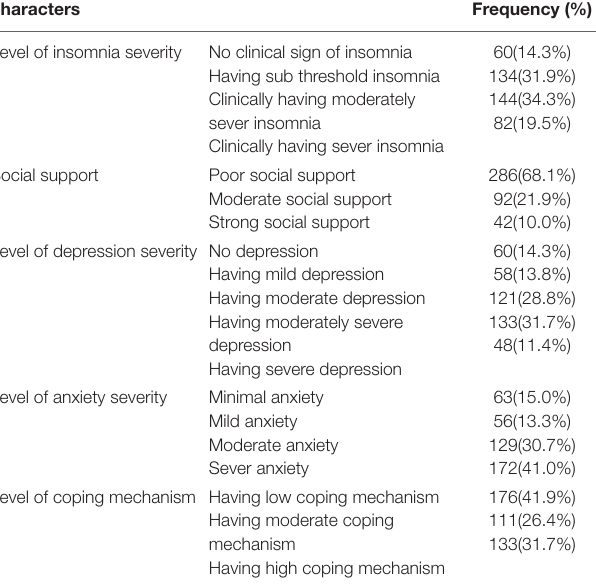
TABLE 3 | Level of severity for insomnia social support, depression, anxiety, and copping mechanism during COVID-19 pandemic among Dessie town prisoners, in Dessie Amhara region, Northeast Ethiopia, October 2020; ( n =